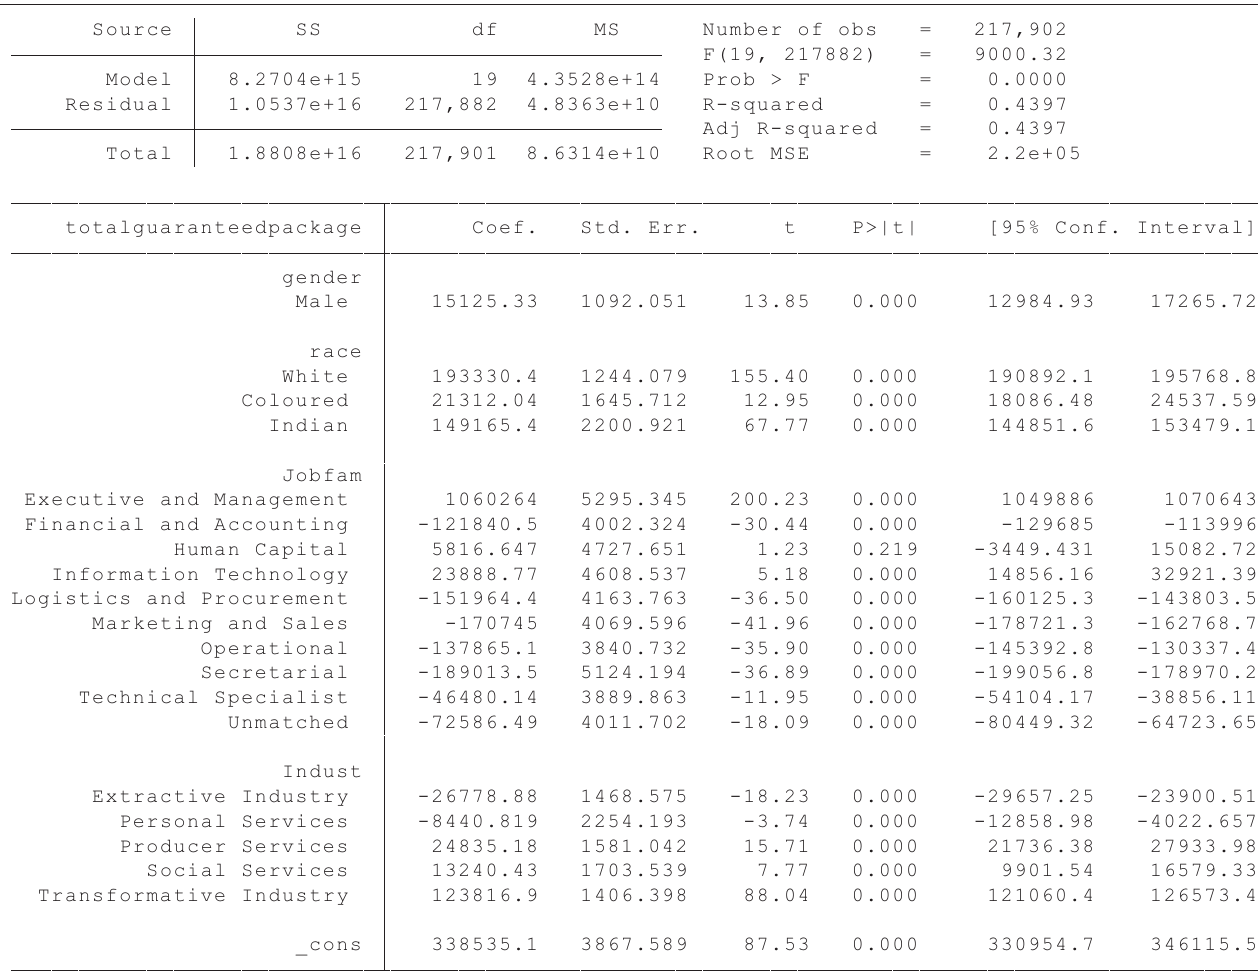
FIGURE 2: Regression model of annual income, gender, race, job family and